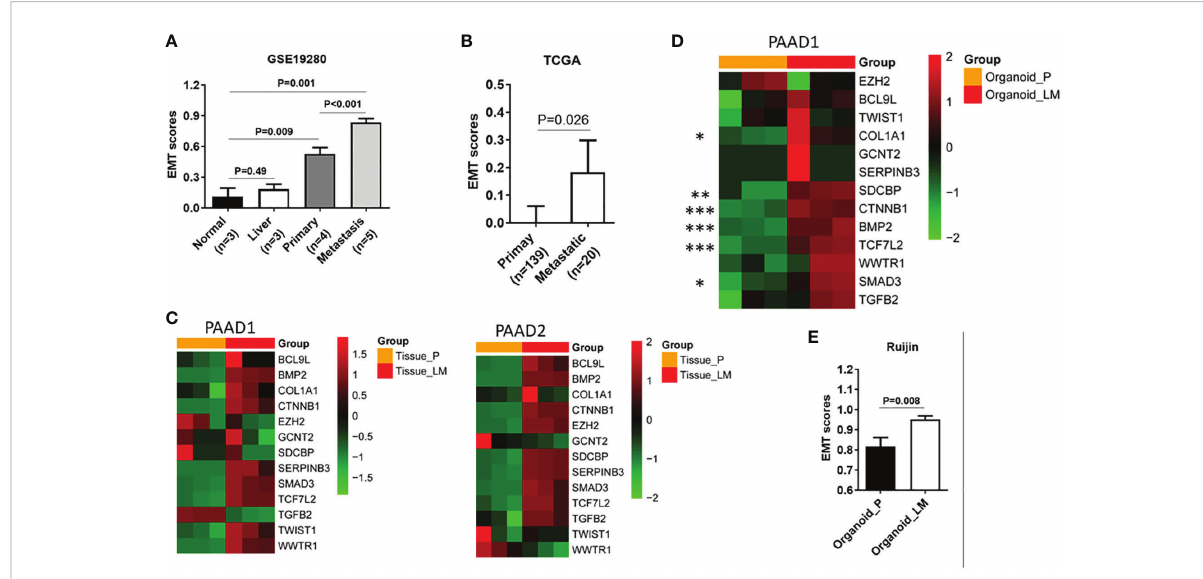
FIGURE 2 EMT signature is signi fi cantly associated with liver metastasis. (A) Expression of GSVA scores in normal tissue, liver tissue, primary lesion, and metastatic lesion of PDAC. (B) Expression of GSVA scores in primary lesions with distant metastases and primary foci without distant metastases in the TCGA database. (C) In our center, heatmap shows expression of 13 genes of EMT-related gene set in primary lesions and metastatic lesions. (D) Heatmap shows the expression of 13 genes in the EMT gene set in organoids derived from metastatic lesions and organoids derived from primary lesions. (E) Expression of GSVA between organoids derived from metastatic tumor and organoid-derived from primary tumor. EMT, epithelial-to-mesenchymal transition; GSVA, gene set variation analysis; PDAC, pancreatic ductal adenocarcinoma; TCGA, The Cancer